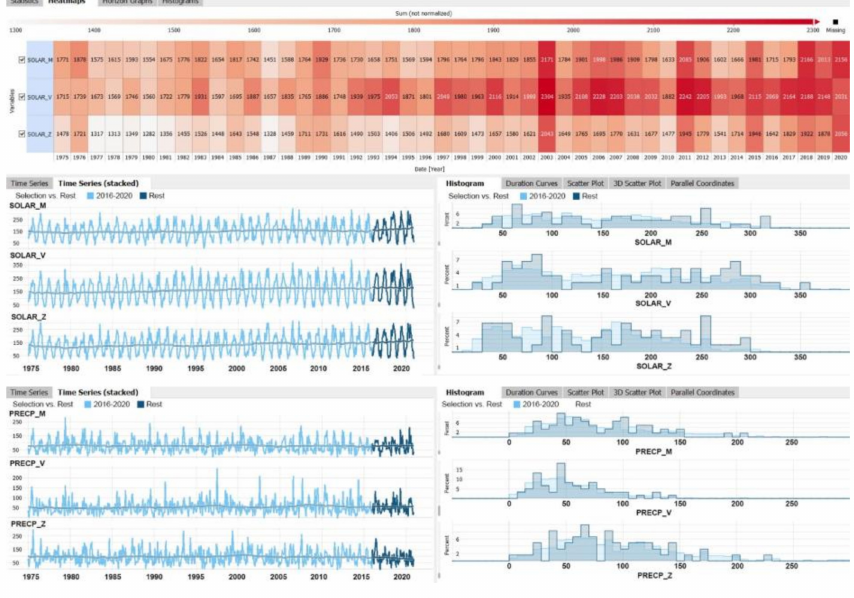
Figure 4. Composite view of solar ( above ) and precipitation ( below ) time-series: heatmap view ( up ), time-series distribution ( down left ), frequency distribution ( down right